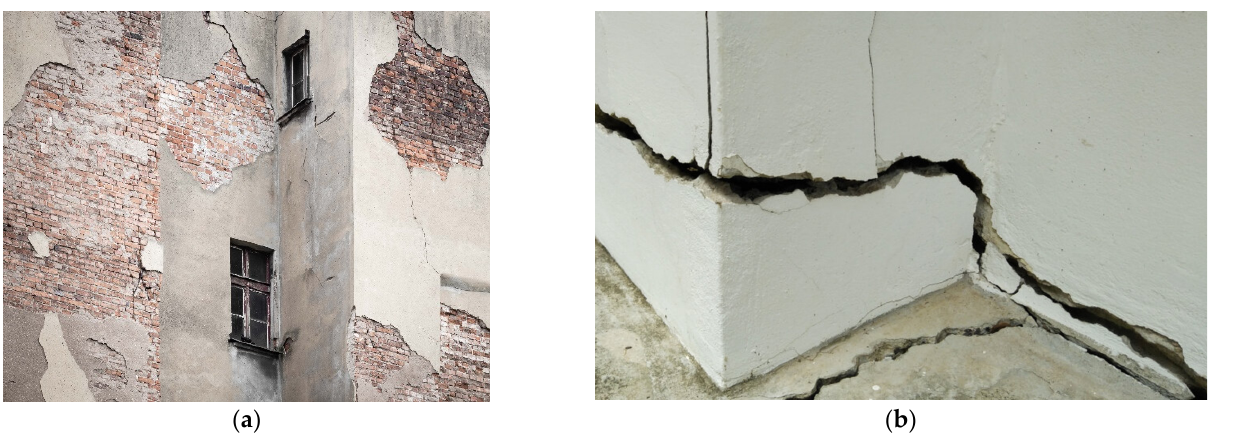
Figure 1. Examples of damage in ( a ) masonry or ( b ) concrete structures ( fi gures reproduced with permission from Unsplash). permission from